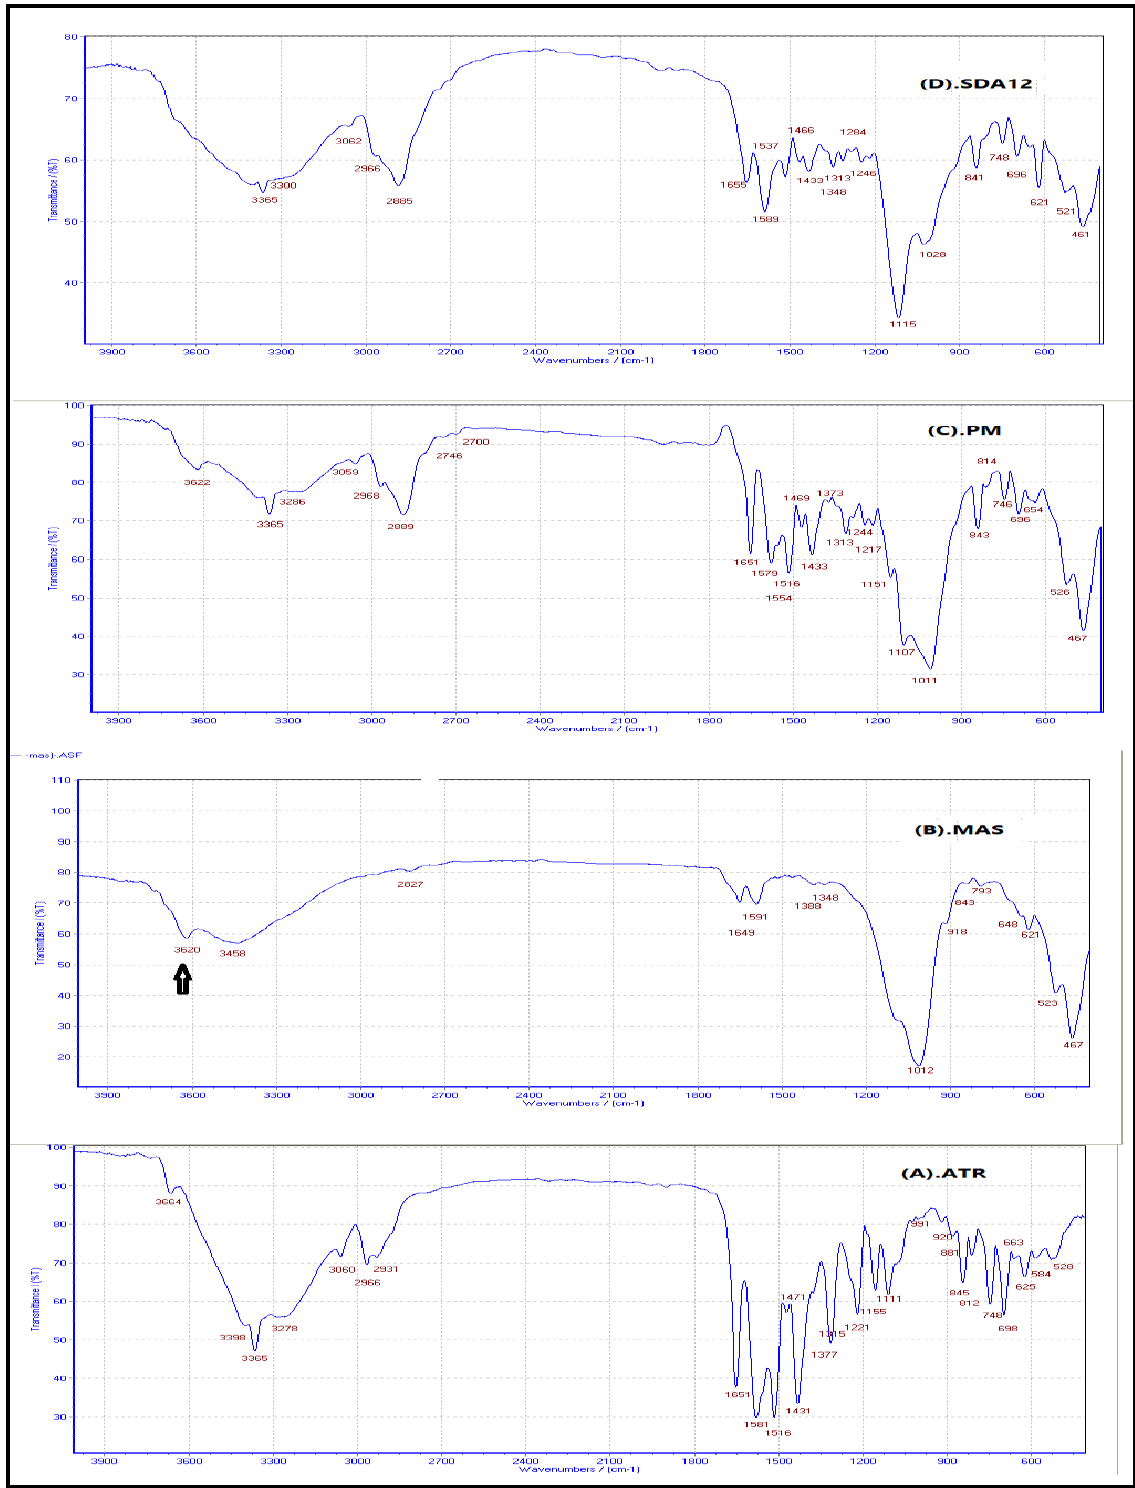
Figure 6. FTIR: ATR(A) , MAS (B) , PM (C) , SDA12 (D) Conclusion dissolution of ATR was obtained by preparing it as solid dispersion adsorbate by melt adsorption method using hydrophilic carriers and adsorbents in a ratio of 1:1:1(drug: carrier: